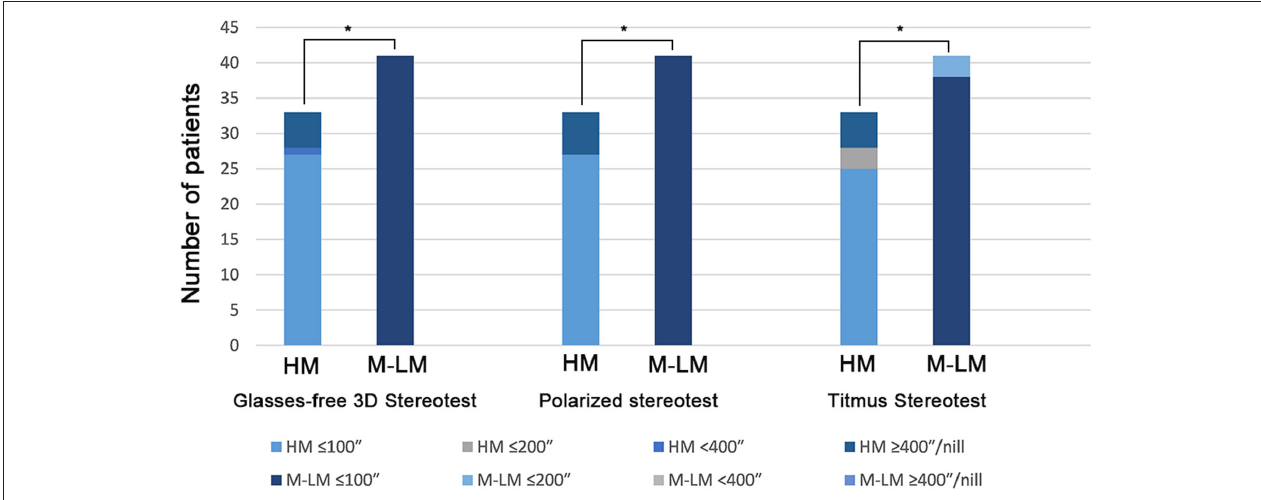
FIGURE 4 | Stereoscopic levels of HM and M-LM groups in three stereotests. HM, high myopia; M-LM, moderate-to-low myopia. *A significant difference between